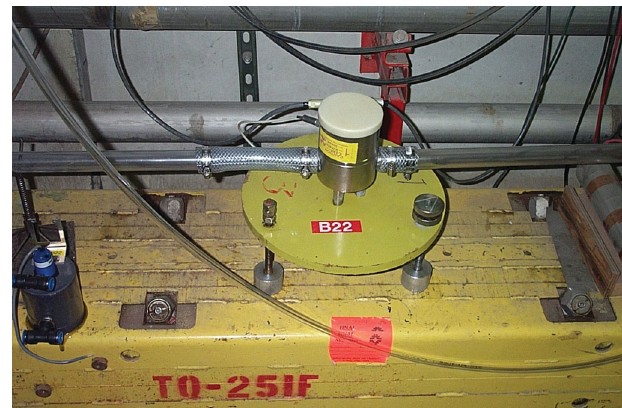
FIG. 37. Change of the elevations of 20 Tevatron magnets after 23 days of observations (January 7–February 1, 2004; from Ref. [30]).